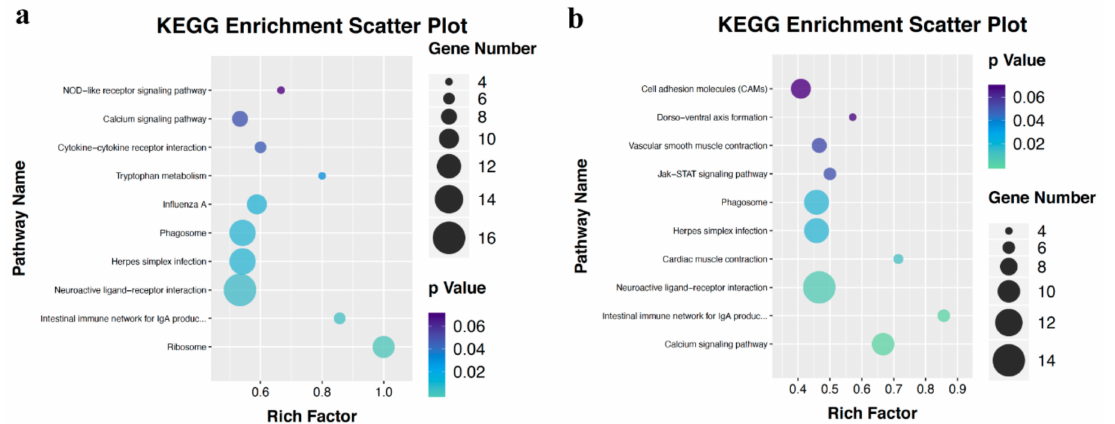
Figure 5. Gene ontology (GO) enrichment analyses of di ff erentially expressed genes. ( a , b ) Top 10 enriched biological processes, cellular compounds, and molecular functions in P-F-O1 vs. P-F-O2 and L-F-O1 vs. L-F-O2. Biological process terms are in blue, cellular compound terms are in purple, and molecular function terms are in green. The Y axes represent GO terms, and the X axes represent − log p value.